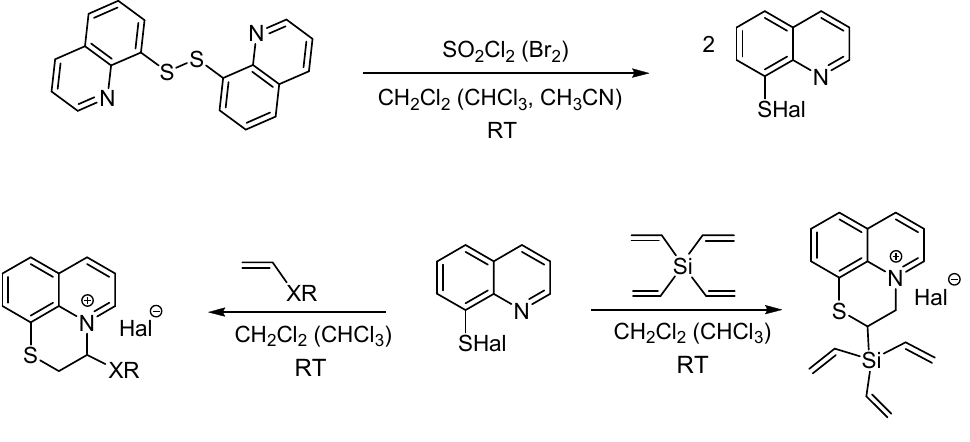
Hal = Cl, Br; XR = OBu-i, OC 2 H 4 Cl. SCH=CH 2 , SPh, SeCH=CH 2 Scheme 1. The generation of 8-quinolinesulfenyl halides from di(8-quinolinyl) disulfide by the action of sulfuryl chloride or bromine followed by the annulation reactions with vinylic ethers, sulfides, divinyl selenide and tetravinyl silane.